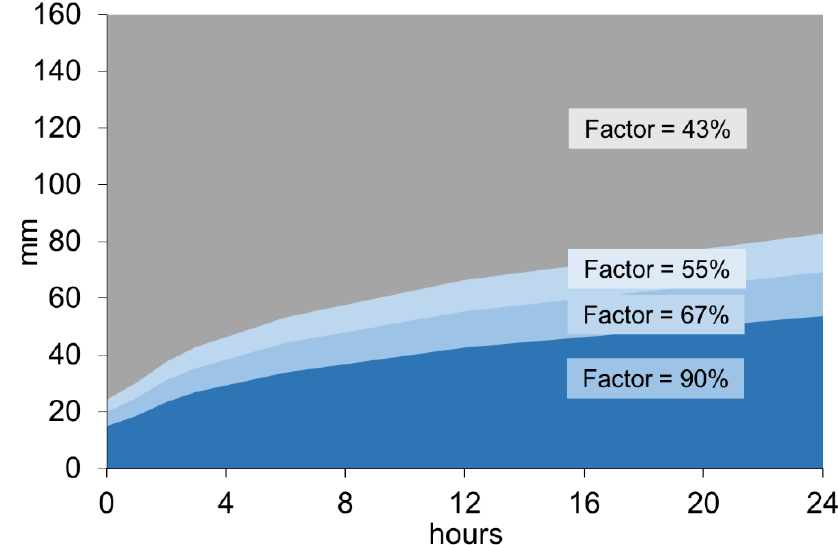
Figure 4. Accounting rule figure for soil group C.